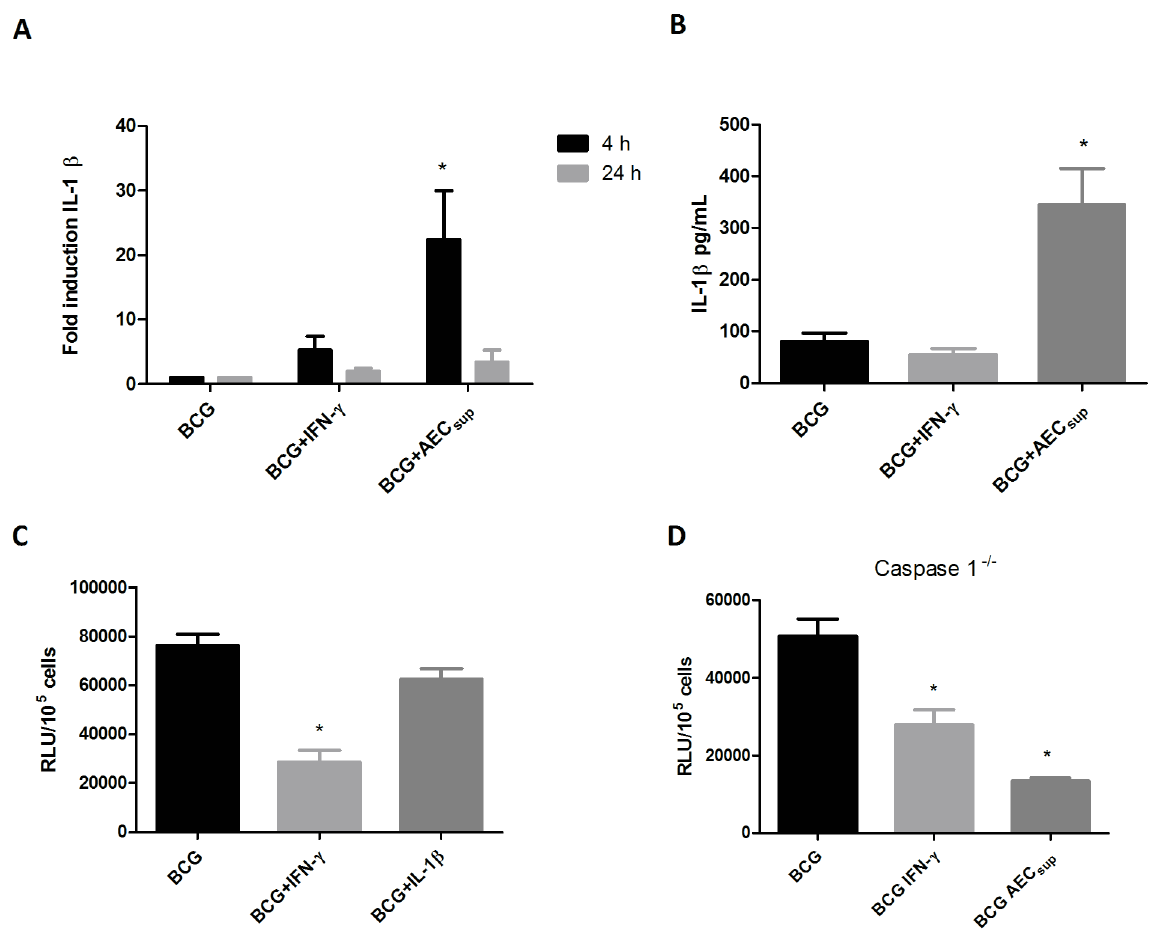
Figure 6. AEC sup induces IL-1 b expression and secretion without an effect of intracellular killing of BCG. BMM and PuM were infected with GFP-BCG. After infection, cells were treated with either IFN- c or AEC sup or left untreated. a) Total RNA was extracted from both cell-types after 4 and 24 h of treatment and the mean-fold accumulation of IL-1 b transcripts shown. Data shows the average of 3 independent experiments. b) Cell culture supernatants were collected 24 h after infection and IL-1 b measured with ELISA. Data shows the average of 6 independent experiments. c) The effect of incubating cells with IL-1 b (1000 pg/ml) on intracellular growth of BCG. Data representative of 3 independent experiments d) The effect of AECs up on intracellular growth of BCG in BMM from caspase1 -/- mice. Bacterial growth was evaluated by determining RLU. Values are expressed as means 6 SD from 5 wells. The data is representative of 2 independent experiments. The differences between groups of BMM were analyzed using a one-way ANOVA followed by Bonferroni‘s Multiple Comparison Test. * significantly different from medium control, P , 0.05.